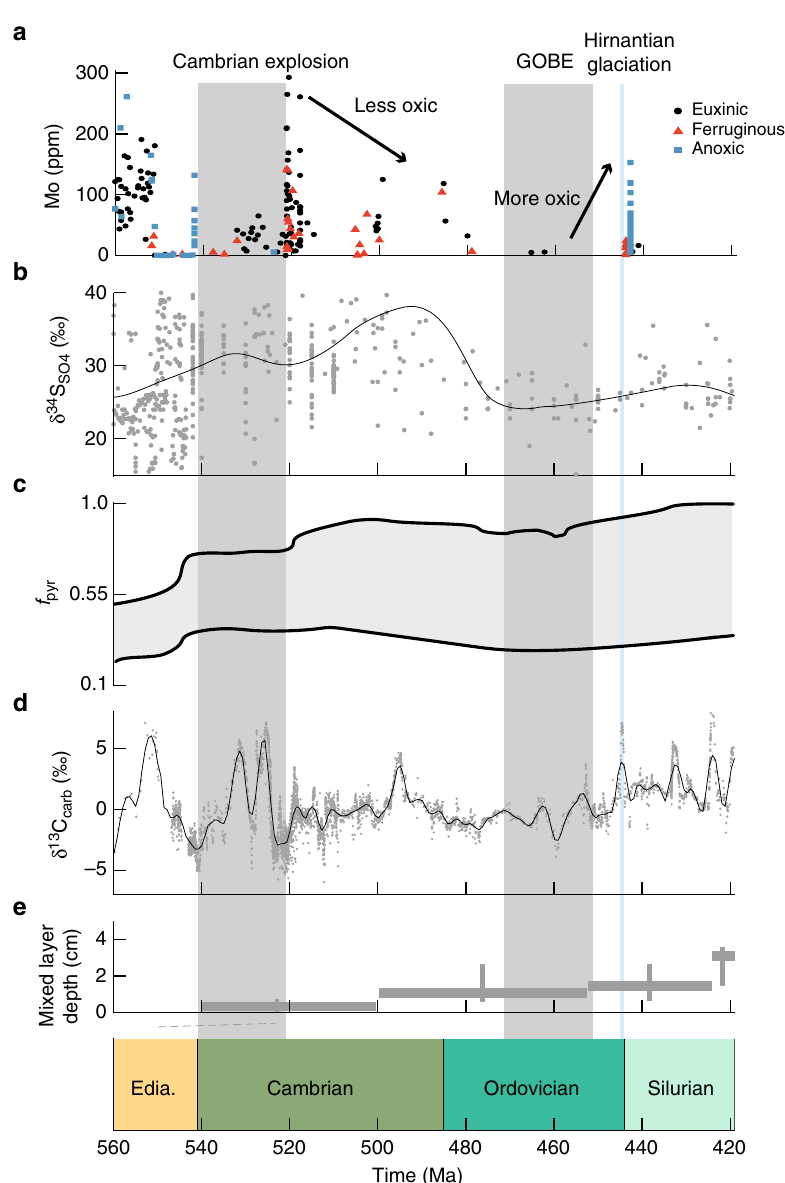
Fig. 1 Compilation of geochemical data from the Neoproterozoic into the Palaeozic. a Mo abundances, as compiled by ref. 29 . Higher oxygen levels lead to higher abundances of Mo. Note that other proxies providing support for the ocean oxygenation state outlined here are compiled in Supplementary Fig. 1. b Sulphate-S isotopes ( δ 34 S SO4 ) as compiled by ref. 69 . δ 34 S SO4 increases through the Cambrian, with a return to lighter values at the GOBE. c Pyrite fraction of sulphur burial ( f pyr = pyrite burial/(pyrite burial + gypsum burial)), full range of estimates, as presented in ref. 44 . d Carbonate-C isotopes ( δ 13 C carb ) as compiled by ref. 70 . Higher values indicate a higher rate of organic carbon burial. e Mixed layer depth, reproduced from ref. 7 . Black lines on panels b and d are local regression (LOESS) fi ts. Grey shaded areas indicate the Cambrian explosion (540 – 521 Ma) and the Great Ordovician Biodiversi fi cation Event (GOBE; 470 – 450 Ma). Blue shaded line indicates the Hirnantian